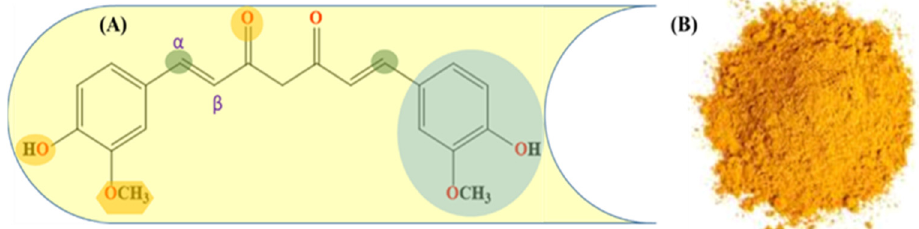
Figure 1. ( A ) Molecular structure of Curcumin showing the active functional group and α , β -unsaturated system; ( B ) dried and powdered rhizome of turmeric (Curcuma